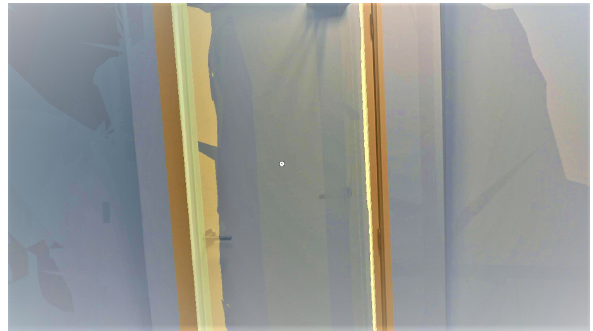
Figure 3. The door was selected as key-object.